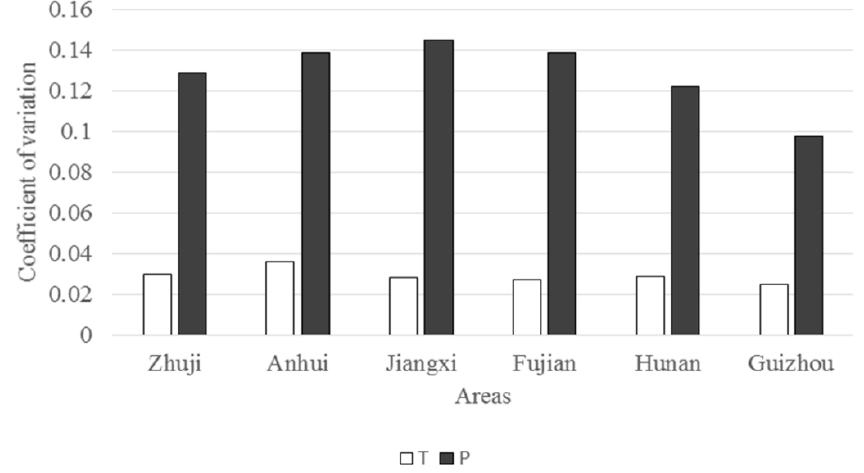
Figure 4. The stability of annual air temperature and precipitation in the six regions. (T: annual air temperature, P: annual precipitation).